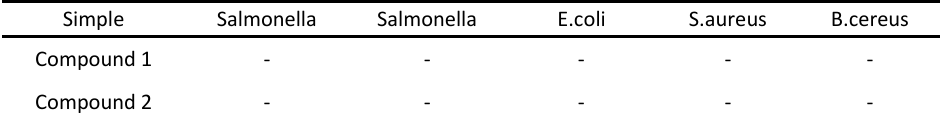
Table 1. Bacterial characteristics of taurine